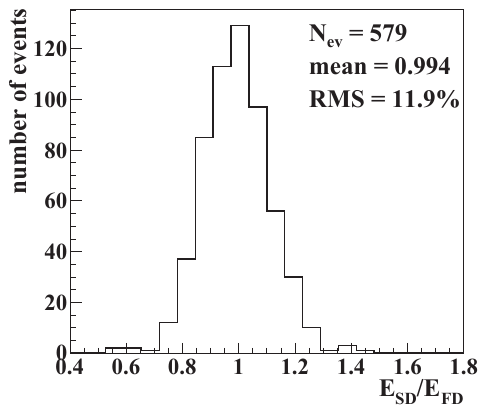
Figure 3. Ratio of the SD to FD energies for the Auger hybrid events above 10 19 eV [7].